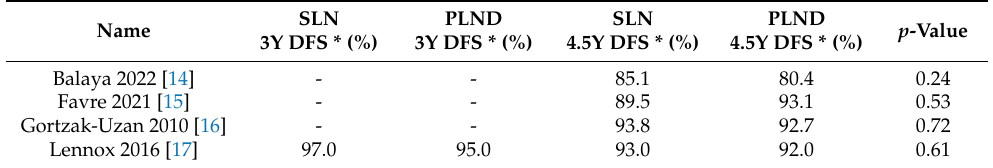
Table 2. Disease-free